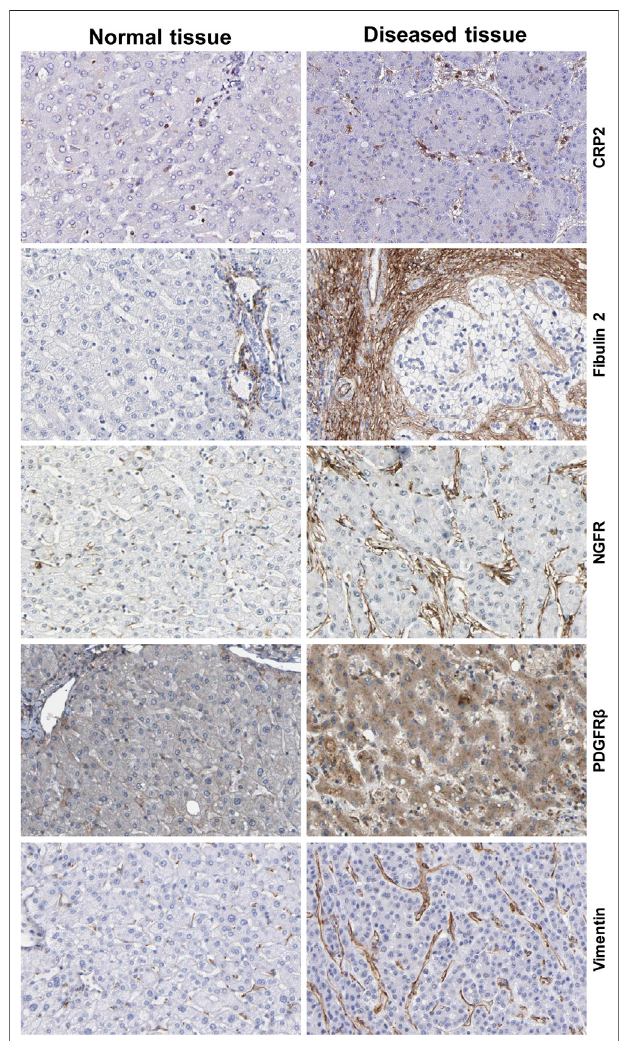
FIGURE 8 | Additional markers of hepatic stellate cells and portal myo fi broblasts. The fi gure was compiled from data deposited from Human ProteinAtlas(www.proteinatlas.org/)(Uhlénetal.,2015).Immunohistochemistry of the cysteine and glycine rich protein 2 (CRP2), Fibulin 2, nerve growth factorreceptor(NGFR),platelet-derivedgrowthfactor- β (PDGFR β )andVimentin in normal and diseased liver tissue. Liver damage is associated with increased expression of these pro fi brogenic markers. Image credit: Human Protein Atlas.